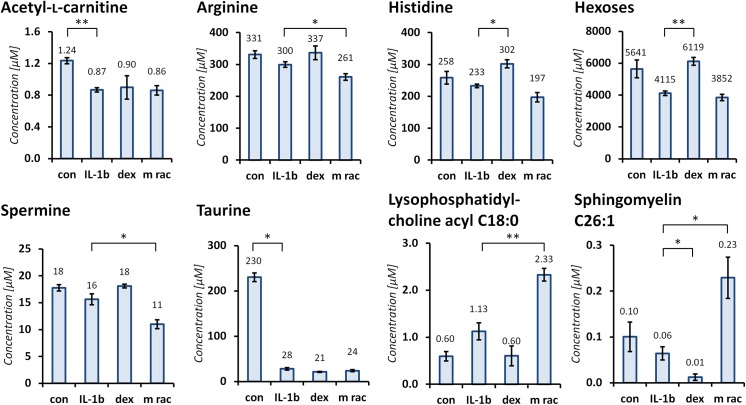
Regulation of selected metabolites assessed by the AbsoluteIDQ p180 metabolomics kit illustrating the contrasting inflammation modulating effects of dexamethasone (dex) and M rac.Again, HUVECs were stimulated with IL-1βeta (IL-1β) and additionally treated with dexamethasone or M rac extract (M rac). Error bars are derived from two technical and two biological replicates. (p-values: *, p<0.05 and **, p<0.005.)